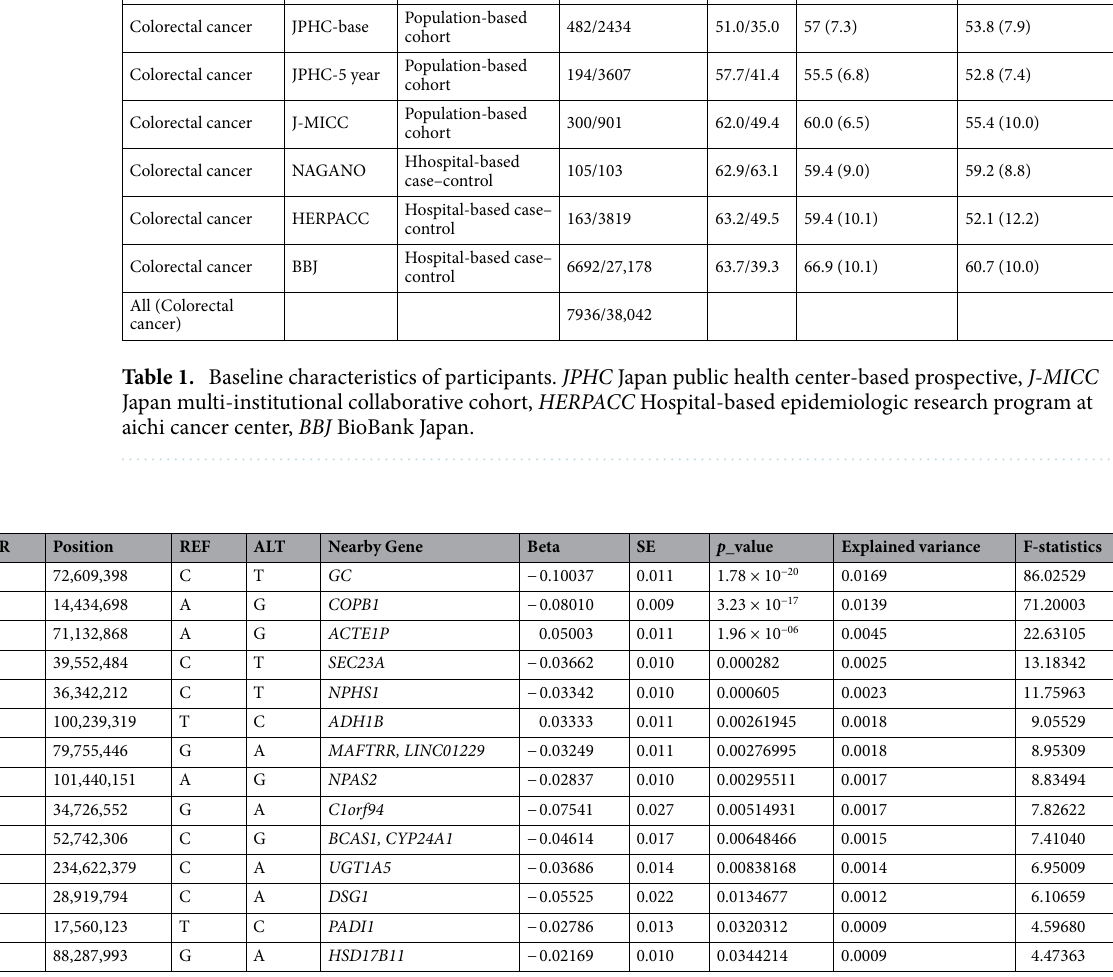
Table 2. Summary statistics of the significant SNPs ( p -value < 0.05) in SNP-exposure association. Chr Chromosome position: Chromosomal Position (hg19), REF Reference allele, ALT Alternative allele, SE Standard error, Approximate F-statistics which is calculated from the formula (beta/se) 2